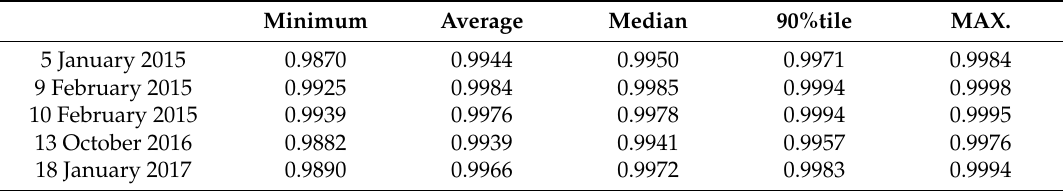
Table 7. Values of five location parameters for the copolar correlation coefficient.